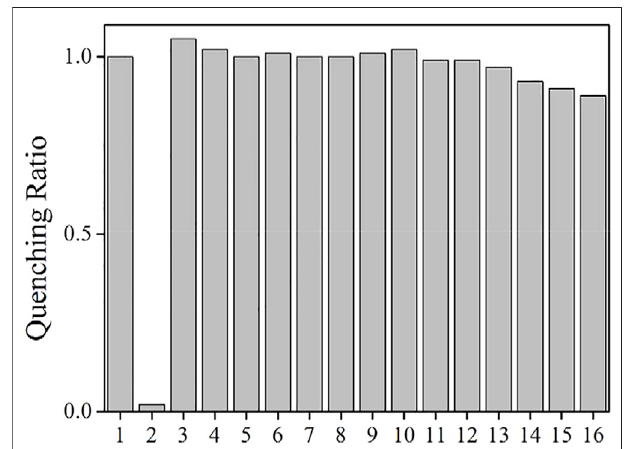
FIGURE 10 | Emission intensity quenching ratio of the AuNCs diluted by pure water (v:v (cid:1) 1:10), in the presence of metal cations and anions (100 μ M). 1 (cid:1) blank, 2 (cid:1) Fe 3+ , 3 (cid:1) AcO − , 4 (cid:1) PO 4 − , 5 (cid:1) SO 4 − , 6 (cid:1) NO 3 − , 7 (cid:1) Na + , 8 (cid:1) Mg 2+ , 9 (cid:1) Ca 2+ , 10 (cid:1) Zn 2+ , 11 (cid:1) Cd 2+ , 12 (cid:1) Co 2+ , 13 (cid:1) Al 3+ , 14 (cid:1) Cu 2+ , 15 (cid:1) Fe 2+ , and 16 (cid:1) Hg + .